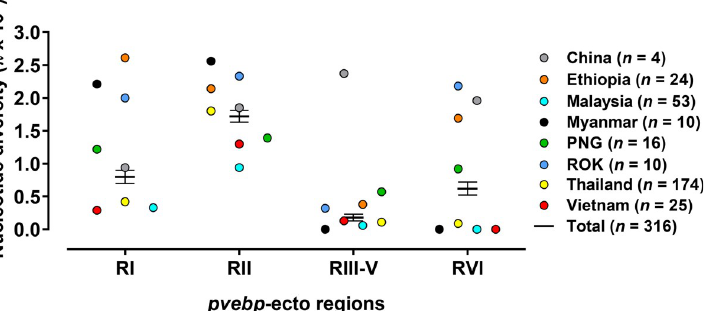
Fig 3. Pvebp domains nucleotide diversity ( π ) based on the geographical areas. PvEBP region divided for region I (RI, 1–534 bp), RII (535–1,437 bp), RIII-V (1,438–2,070 bp), and RVI (2,071–2,307 bp) based on the PvDBP homologue